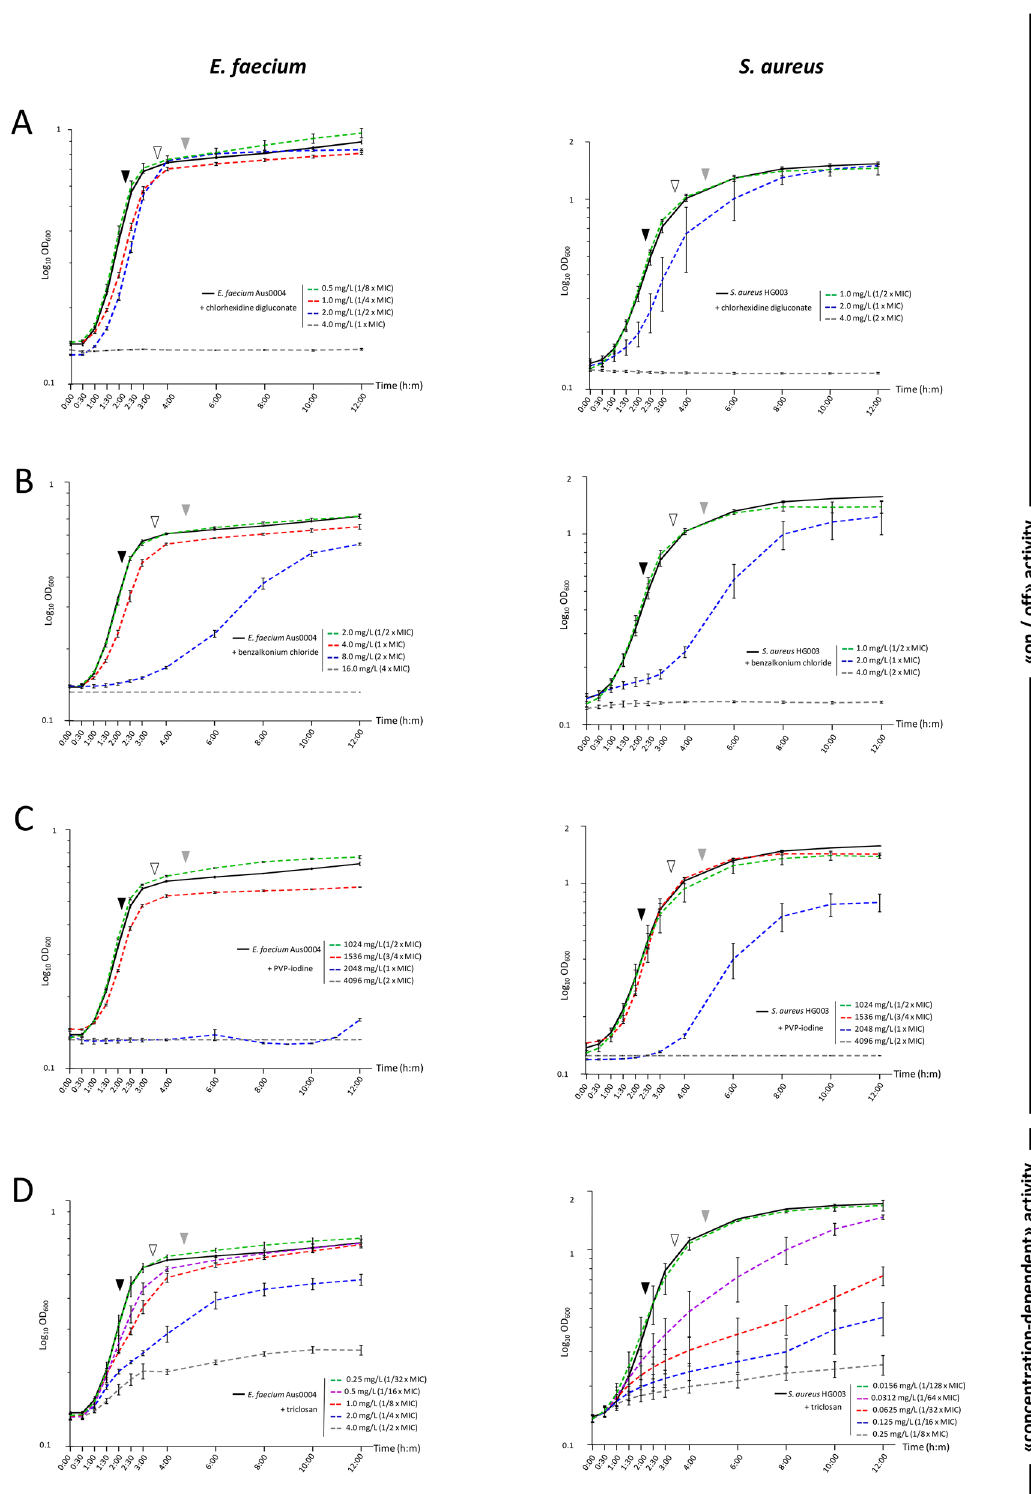
Figure 1. Growth kinetics of E. faecium Aus0004 (lefts panels) and S. aureus HG003 (right panels) under gradients of chlorhexidine (range from 0.5 to 4.0 mg/L) ( A ), benzalkonium chloride (range from 1.0 to 16.0 mg/L) ( B ), PVP-iodine (range from 1024 to 4096 mg/L) ( C ) and triclosan (range from 0.0156 to 4 mg/L) ( D ). Growth curves under sub-inhibitory concentrations (SICs), defined as the highest concentration of biocide for which the standard deviation of the growth curve overlapped with the one of the biocide-free control, are represented in green dashed line. Growth stages considered for sRNA expression corresponded to mid (ME, full black triangle), late (LE, empty black triangle) exponential growth and early stationary (ES, full grey triangle) phases. Error bars indicate standard deviations from three independent